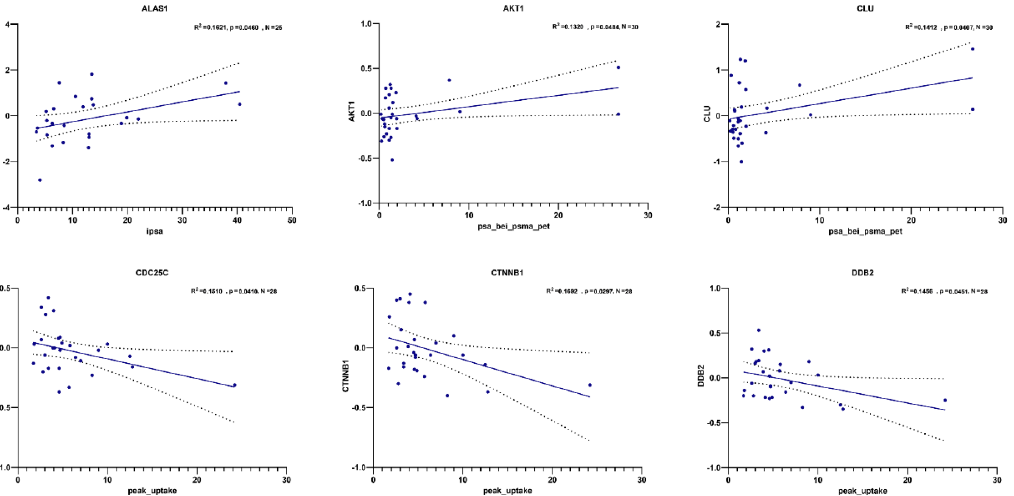
Figure 9. Correlations between transcripts’ expression in blood-derived mRNA and PSA-related standard clinicopathologic variables in ADT− cohort. Scatter plots showing correlation between − log10 relative expression levels of gene transcripts (on the y -axis) and different clinical parameters (on the x -axis). Pearson correlation R2 values are indicated, along with p values and N (number of observations/patients). In each graph, linear regression is denoted by the dark blue line and error bars are indicated by the black dotted lines.